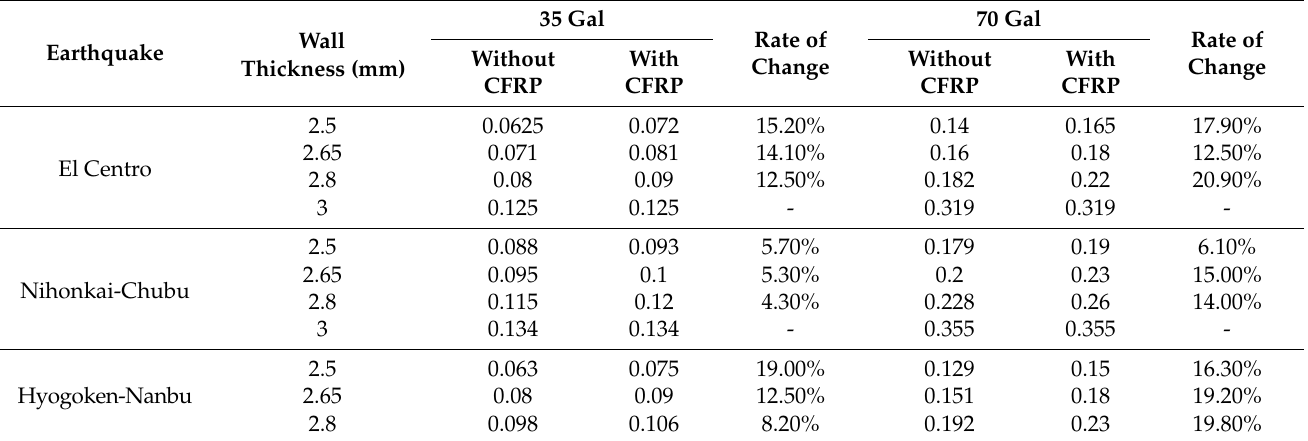
Figure 30. Comparison of structural dynamic response under El Centro earthquake: ( a ) Acceleration Peak comparison; ( b ) Displacement peak comparison. Table 9. Comparison of structural acceleration response.